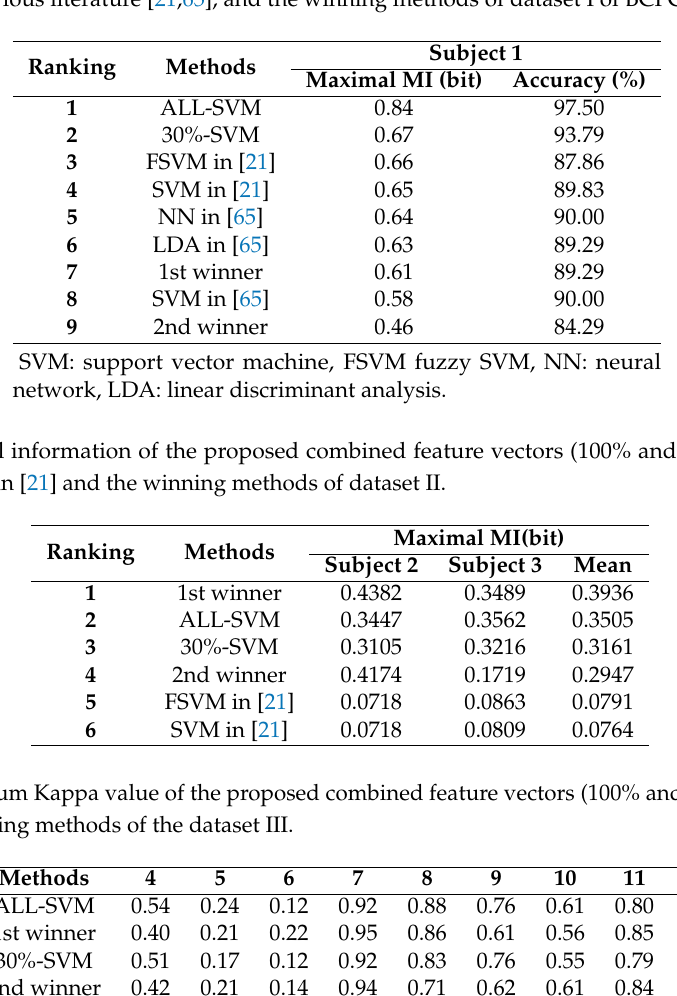
Table 3. Mutual information of the proposed combined feature vectors (100% and 30% of training data), methods in previous literature [21,65], and the winning methods of dataset I of BCI Competition II.